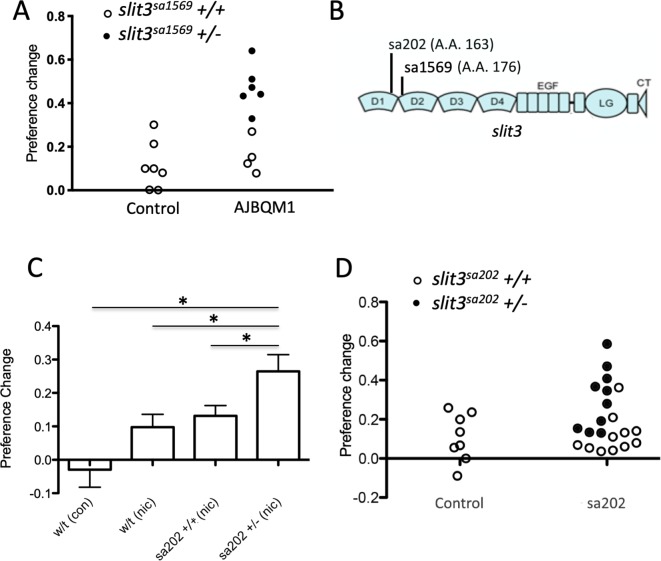
slit3 mutations segregate with nicotine place preference.(A) Segregation of slit3sa1569 mutation with nicotine seeking. CPP change scores for individual un-mutagenized TLF wild type fish (n = 7) and AJBQM1 fish (n = 10). Following CPP analysis, fish were genotyped for 25 loss of function mutations contained within the family. Black dots indicate slit3sa1569/+ heterozygous mutant fish. White dots indicate slit3sa1569+/+ fish. Heterozygosity for slit3sa1569 segregates with increased nicotine seeking behaviour. (B) Position of ENU-induced mutations in zebrafish Slit3 protein. slit3sa1569 (A > G transition) disrupts a splice site in intron seven affecting translation at amino acid 176. slit3sa202 (G > T transversion) introduces a stop codon at amino acid 163. Both mutations truncate the protein before the leucine rich repeat domain 2 (D2), which interacts with membrane bound ROBO during SLIT-ROBO signalling. (C) Nicotine preference of slit3sa202 line. slit3sa202/+ fish (n = 18) show increased nicotine preference compared to wild type TLF controls (n = 8) (p=0.001) and wild type siblings slit3+/+ (n = 14) (p<0.05). Bars indicate mean + SEM. (D) Segregation of slit3sa202 allele with nicotine seeking. CPP change scores for individual un-mutagenised TLF wild type parent strain fish (n = 8) and slit3sa202 fish (n = 21). Black dots indicate slit3sa202/+ heterozygous mutant fish, white dots indicate slit3sa202+/+ fish. Mutations in slit3sa202 co-segregate with nicotine preference. Heterozygous slit3+/sa202 present increased place preference compared to slit3sa202+/+ siblings (n = 11).